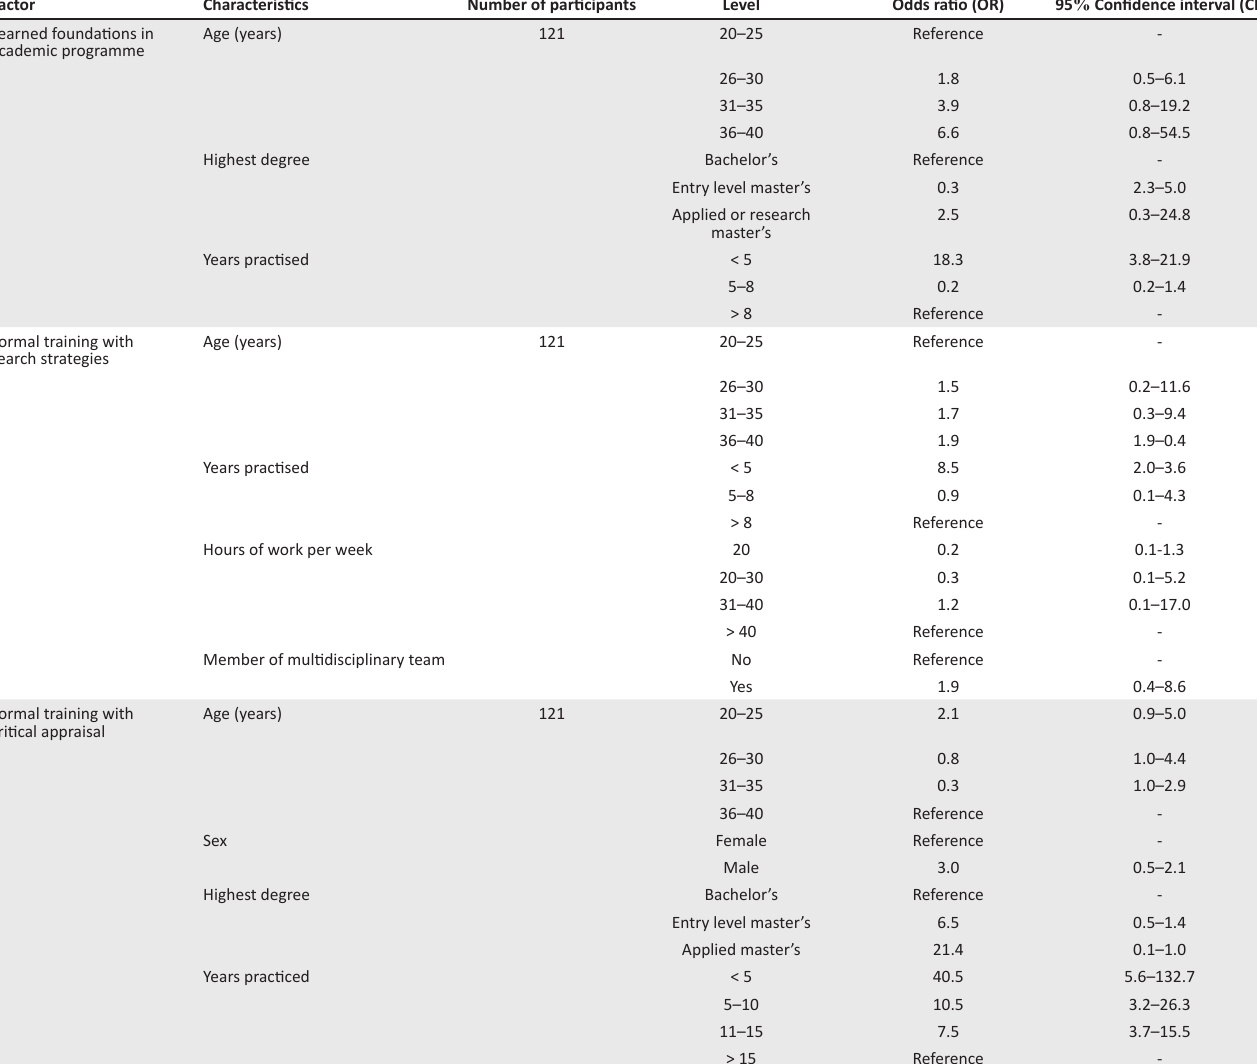
TABLE 4: Relationships between socio-demographic and practice characteristics and evidence-based physiotherapy practice.